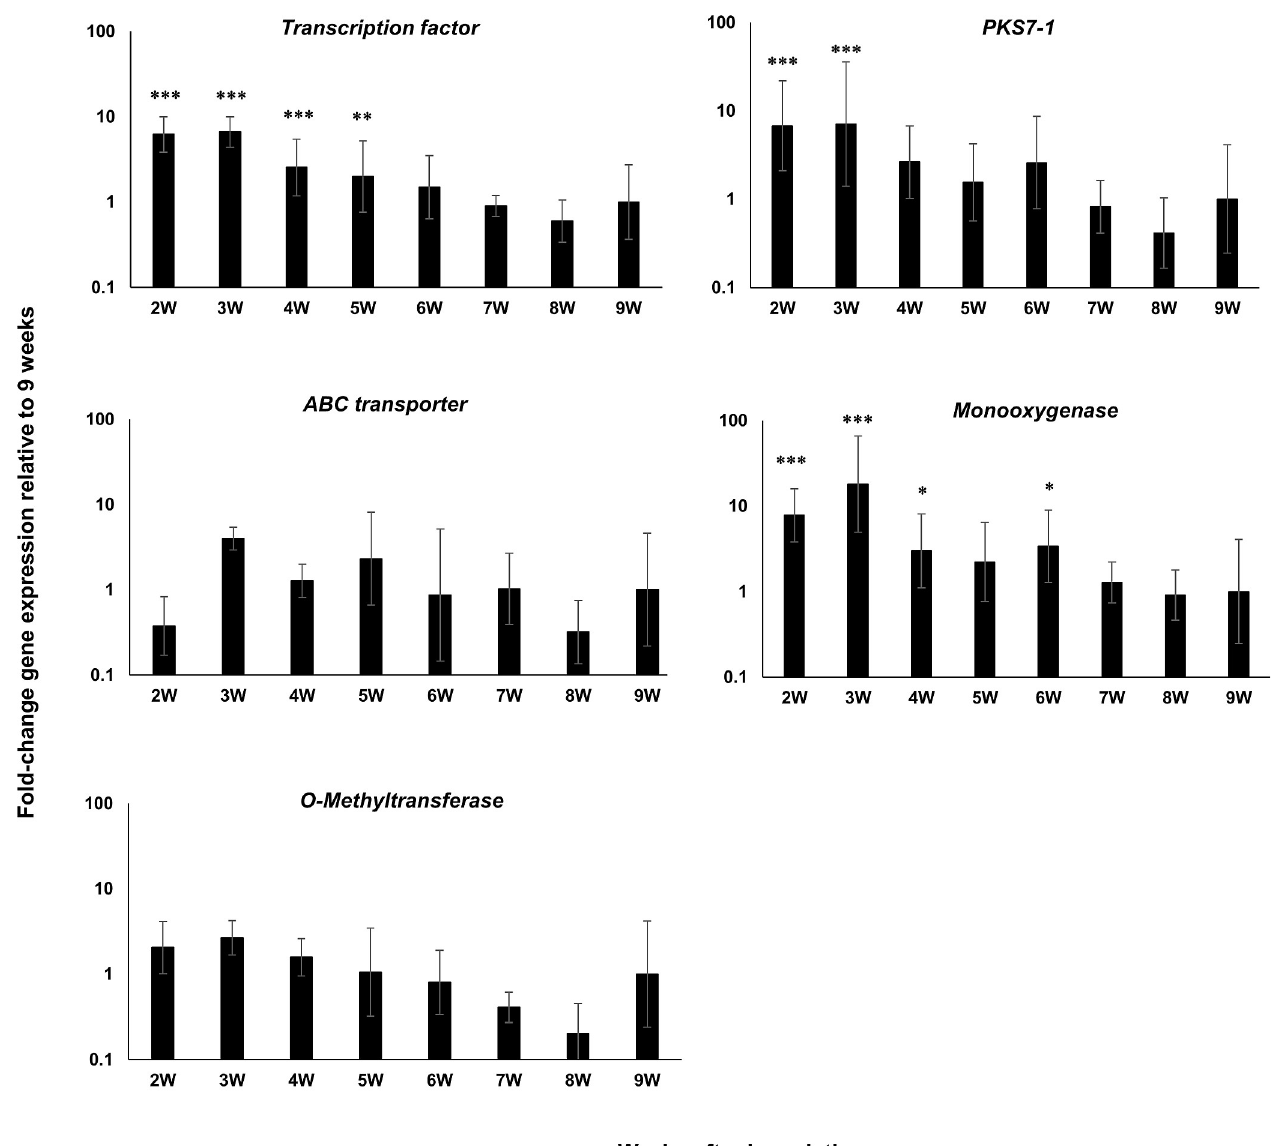
Fig 2. Time course of fold-change gene expression of PKS7-1 cluster genes in wild type P . fijiensis isolate 10CR1-24 in infected banana relative to expression at 9 weeks. PKS7-1 cluster genes assessed include the Zn(II)2 CYS6 transcription factor, PKS7-1 , the ABC transporter, the monooxygenase/ hydrolase, and the O-methyltransferase genes. Tissue was harvested and assayed weekly starting at 2 weeks post-inoculation through 9 weeks. Samples were normalized with reference genes indicated in Table 1. Fold-change gene expression is shown relative to the expression at 9W post-inoculation that is set to 1. Statistical significance was assessed using one-way ANOVA combined with Dunnett’s multiple comparison analysis using the normalized transcript of the 9W sample as the control group. Differences in gene transcript levels considered statistically significant are denoted by asterisks ( � P < 0.05, �� P < 0.01, and ��� P < 0.001). Error bars indicate standard error from three biological replicates. Each biological replicate was tested with three technical replicates.